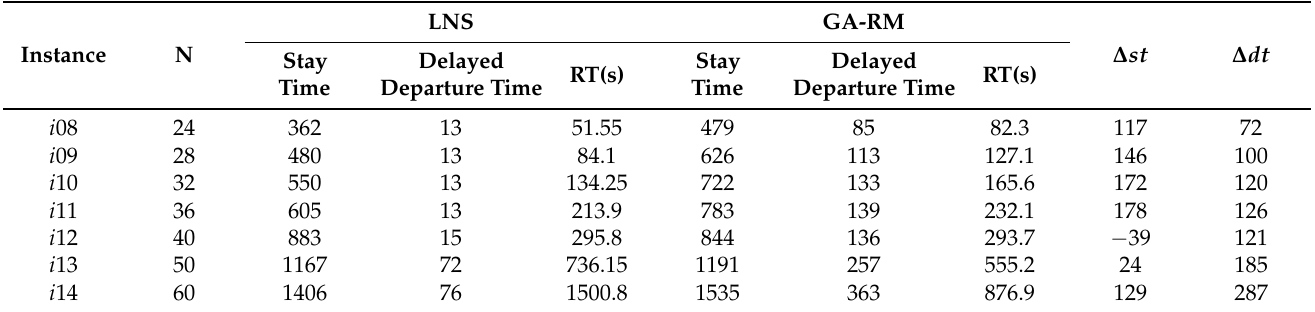
Table 7. The statistical results of stay time and delayed departure time of vessels.